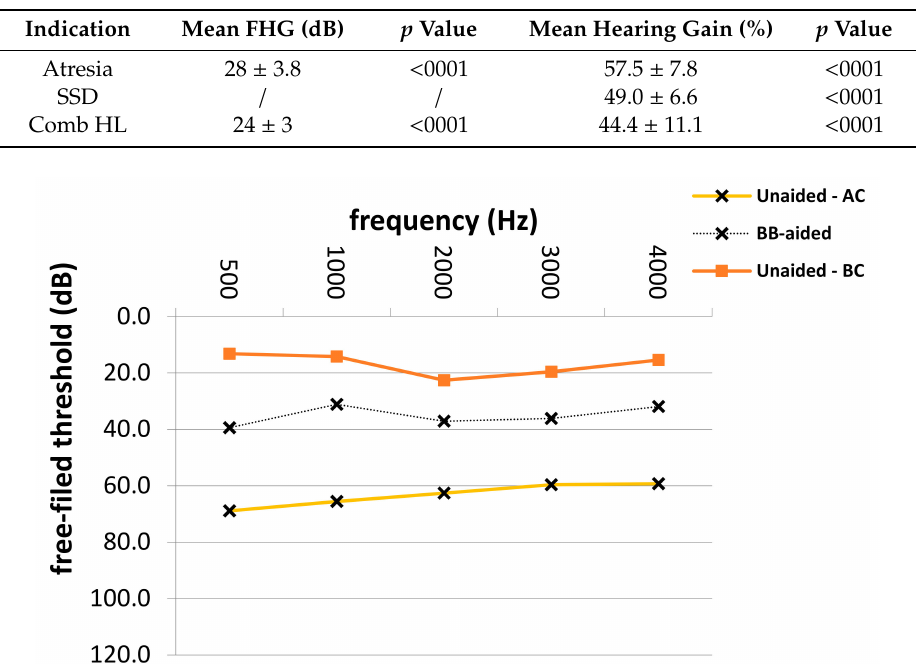
Table 3. Functional gain (FG) and mean WRS improvement.